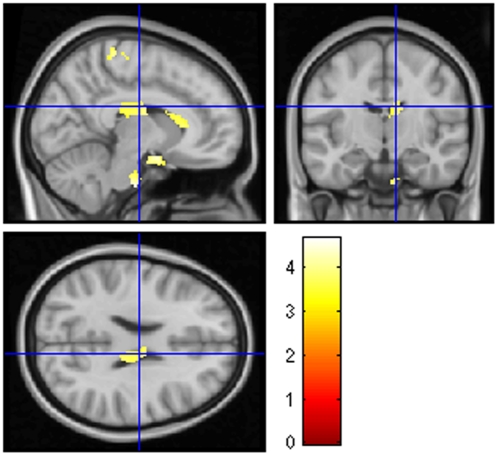
Correlation between performance on PASAT 3 seconds and regional white matter volumes of 28 NMO patients, using VBM.Note the correlations with corpus callosum and the pons. Statistical maps were thresholded without correction, with P value <0.001 and with a minimum cluster size of 30 voxels.